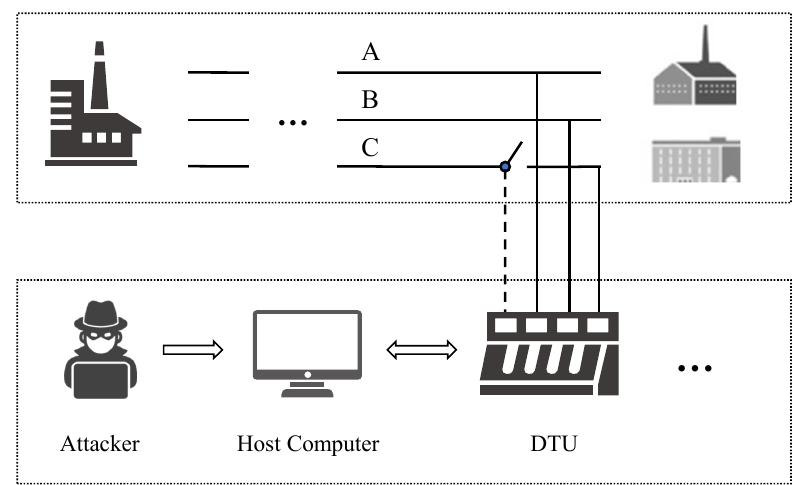
Figure 1. Various security issues have been introduced due to the excessive number of terminal devices in the smart